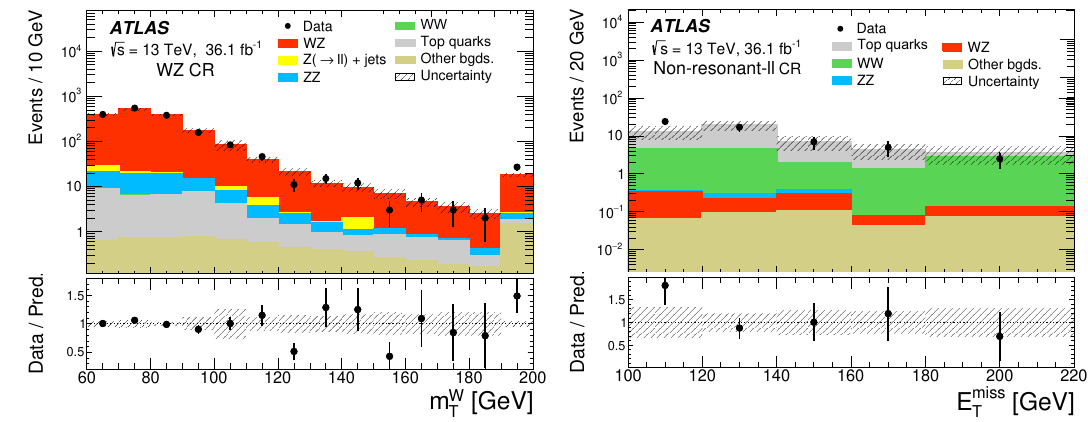
Figure 4 . Distributions in the control regions (CR), of m W for the non-resonant- ‘‘ CR (right). The data are compared with the predictions from simulation, where the WZ contribution is scaled by the normalisation factor of 1 : 26 described in the text. The last bin in the distributions contains the over(cid:13)ow events. The hashed bands include both the statistical and experimental uncertainties. The \other" background corresponds to the V V V and t (cid:22) tV